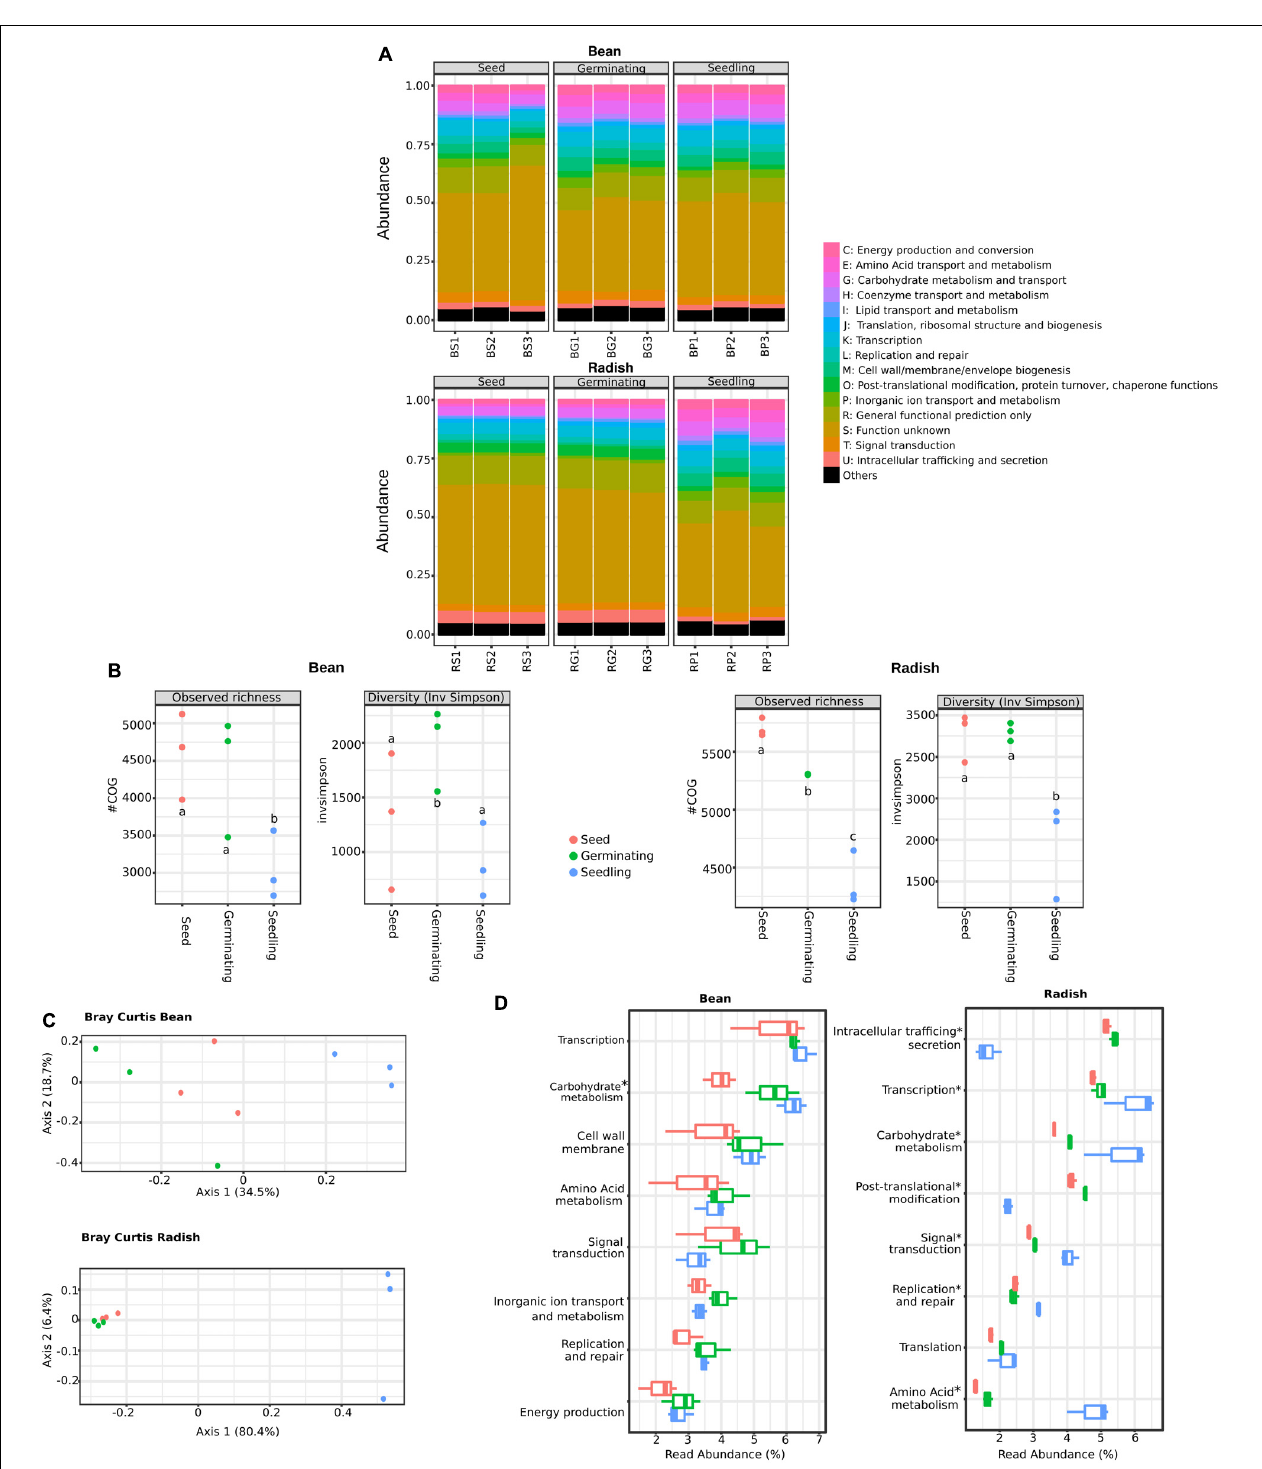
FIGURE 2 | Functional composition of microbial assemblages associated to seeds, germinating seeds and seedlings. (A) Relative abundance of COGs functional categories in the predicted proteomes of the samples investigated. (B) Changes in COGs richness (left panels) and diversity (right panels) among the samples investigated. Letters indicate differences between individual means as assessed with one factor ANOVA with post hoc Tukey HSD ( P < 0.01). (C) PCoA plots based on Bray-Curtis index calculated on COGs table. (D) Abundant functional categories in the samples investigated. Of note is that the functional categories S (function unknown) and R (general functional prediction only) were not reported in this panel. Asterisks ( ∗ ) indicate taxa that are significantly more abundant in seedling samples in comparison to seeds [ANOVA with post hoc Tukey HSD ( P < 0.05)].